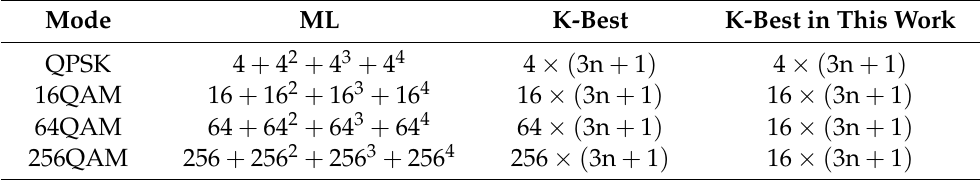
Table 1. Number of search nodes under different modulation modes (K = n).